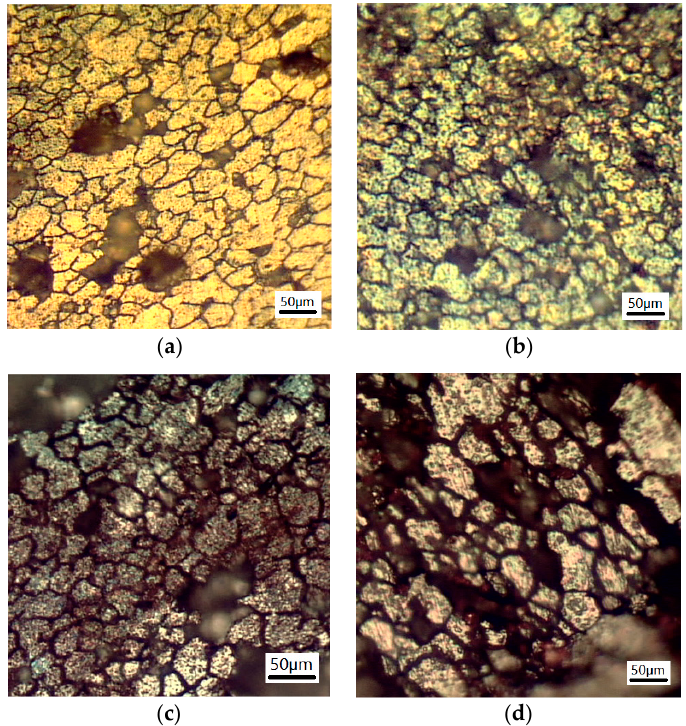
Figure 5. Influence of duration of exposure to the environment on morphology of corrosion experienced by test specimens of aluminum alloy 2219 containing the FSW joint: ( a ) duration of exposure = 8 h; ( b ) duration of exposure = 16 h; ( c ) duration of exposure = 24 h; ( d ) duration of exposure = 48 h.